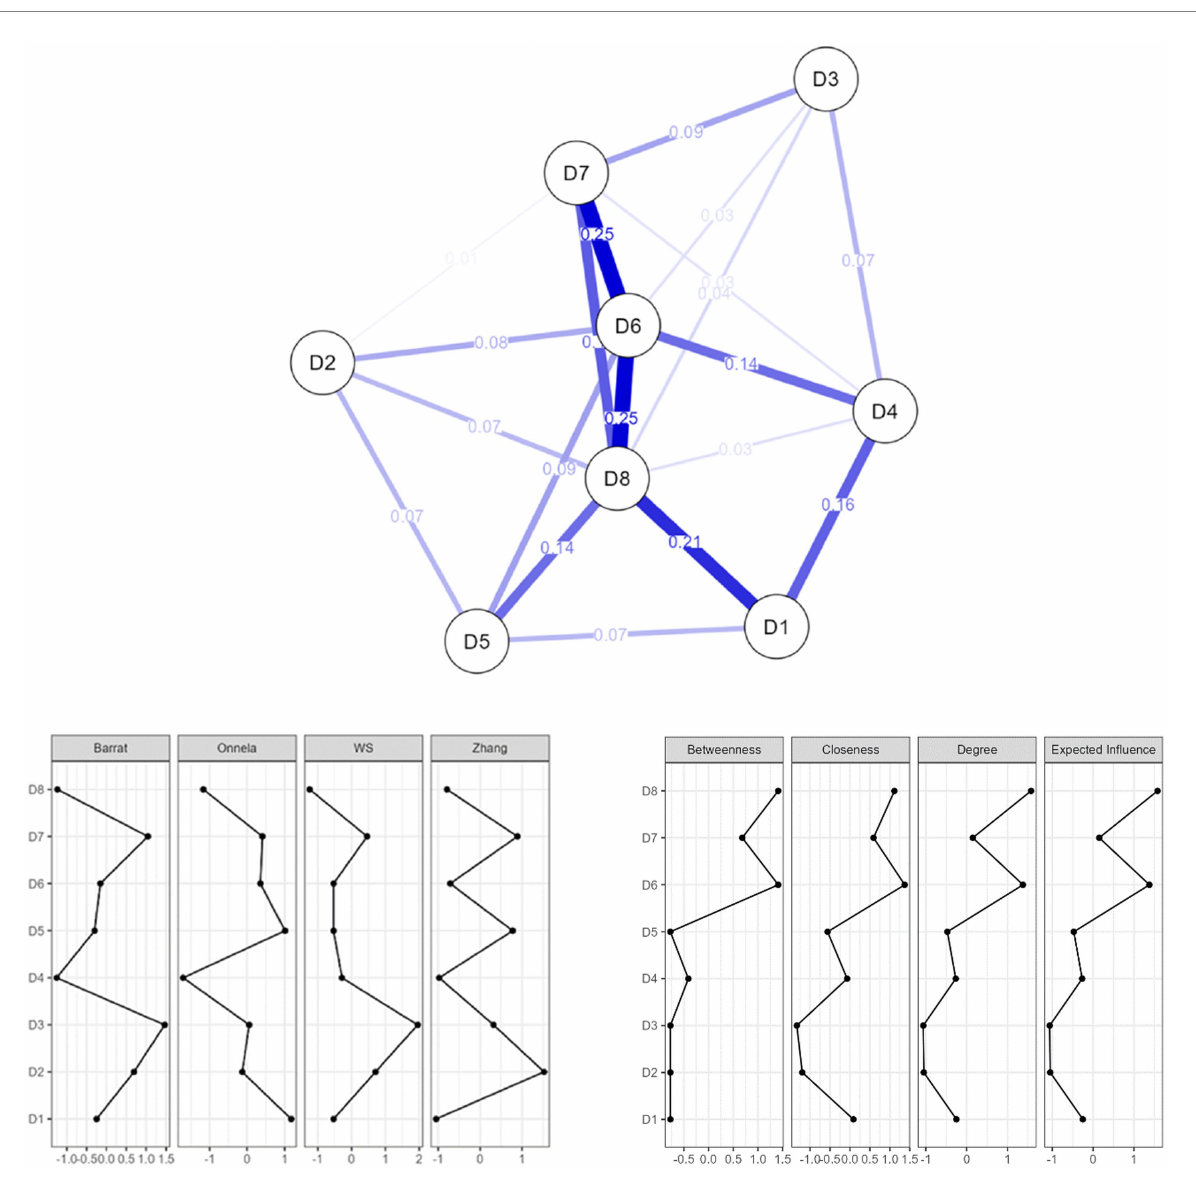
FIGURE 3 Network analysis centrality and clustering plot of the 8 dimensions of IQIB-ECEC